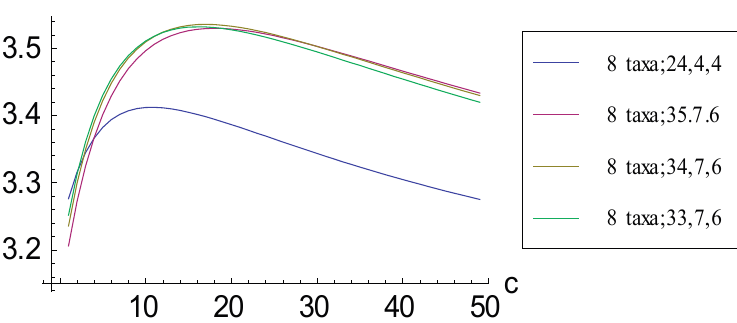
Figure 7. Plots relating information measure I and added autapomorphic characters c for some consistent basal matrices for eight taxa. The representation corresponding to the pectinate cladogram is (8 taxa; 35, 7, 6), whereas the representation corresponding to the symmetric cladogram is (8 taxa; 24, 4,